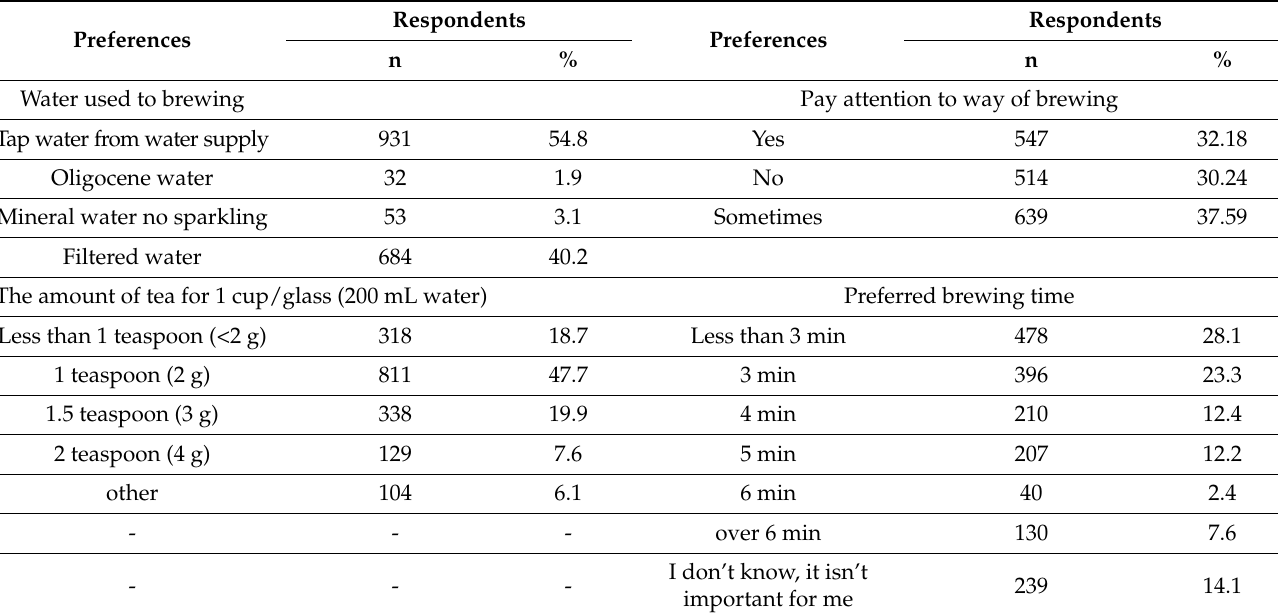
Table 3. Respondents preferences during the preparation of tea